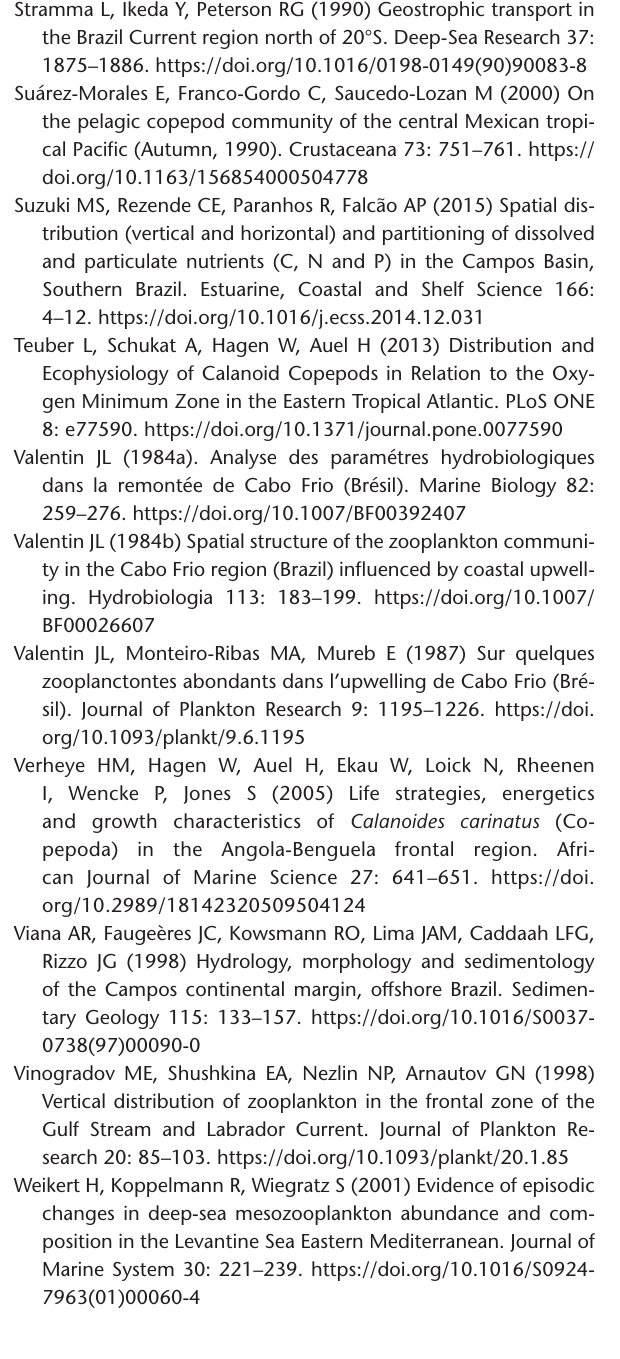
Table S1. Vertical distributions of the mean, standard de- viation (SD), relative abundance (RA), and occurrence fre- quency (OF) of the copepod species found in Campos Basin, during the rainy season.